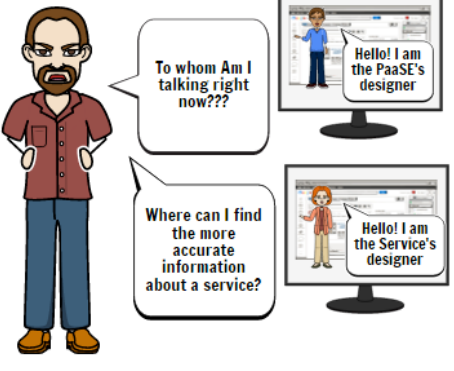
Fig. 11. Not so happy PaaSE user.